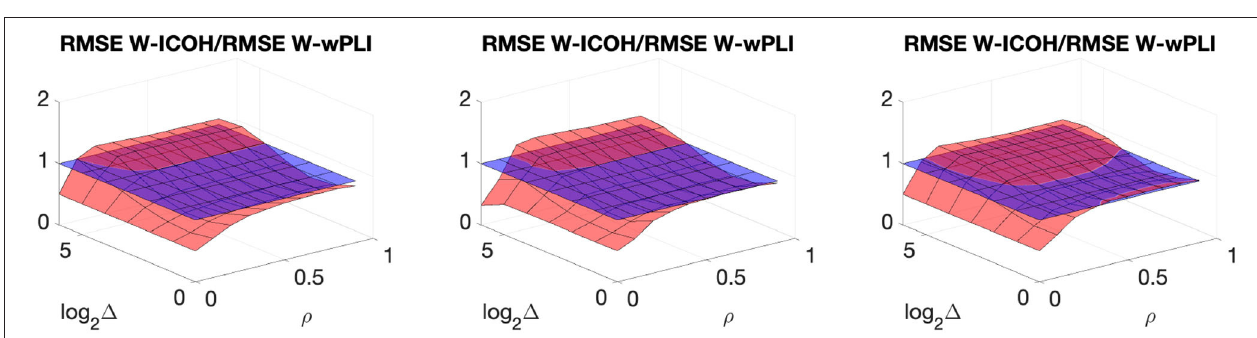
FIGURE 6 | Ratio of the RMSE of W-ICOH to the RMSE of W-wPLI, averaged across scales 3 ≤ j ≤ 7, as functions of delay 1 and correlation coefficient ρ , for the synthetic data in Figures 3 – 5 . Horizontal blue plans indicate the constant level of 1 to ease